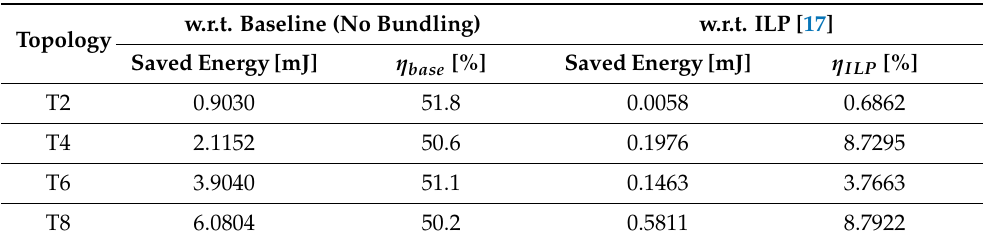
Table 7. Summary of the energy saved by the proposed optimal message bundling scheme (INLP) with respect to the baseline (no bundling) and the ILP model [17].